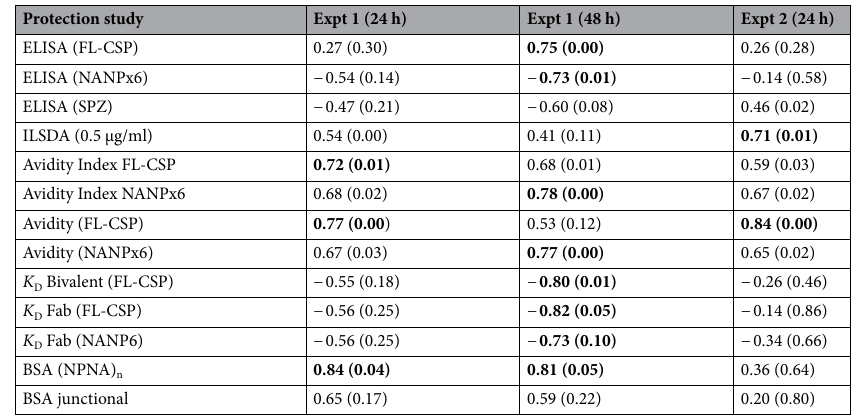
Table 2. Correlation analysis. Pearson’s correlation coefficient r and the level of significance (bracket) between in vivo challenge ( Experiment 1 and 2 ) and in vitro assays. Assays included FL-CSP ELISA; NANPx6 ELISA; Sporozoite ELISA; ILSDA at 0.5 µg/ml; Avidity Index (AI) against FL-CSP; AI against NANPx6; Avidity against FL-CSP; Avidity against NANPx6; K D Bivalent against FL-CSP; KD Fab against FL-CSP; K D Fab against NANP6; Buried Surface Area between mAb and (NPNA)n epitope and BSA against junctional epitope. Pearson’s correlation coefficient | r |> 0.7 suggested a strong linear association; | r |= 0.4–0.7 suggested moderate linear association; and no linear association was inferred for | r |< 0.4. Bold values are | r |> 0.7 ( p <